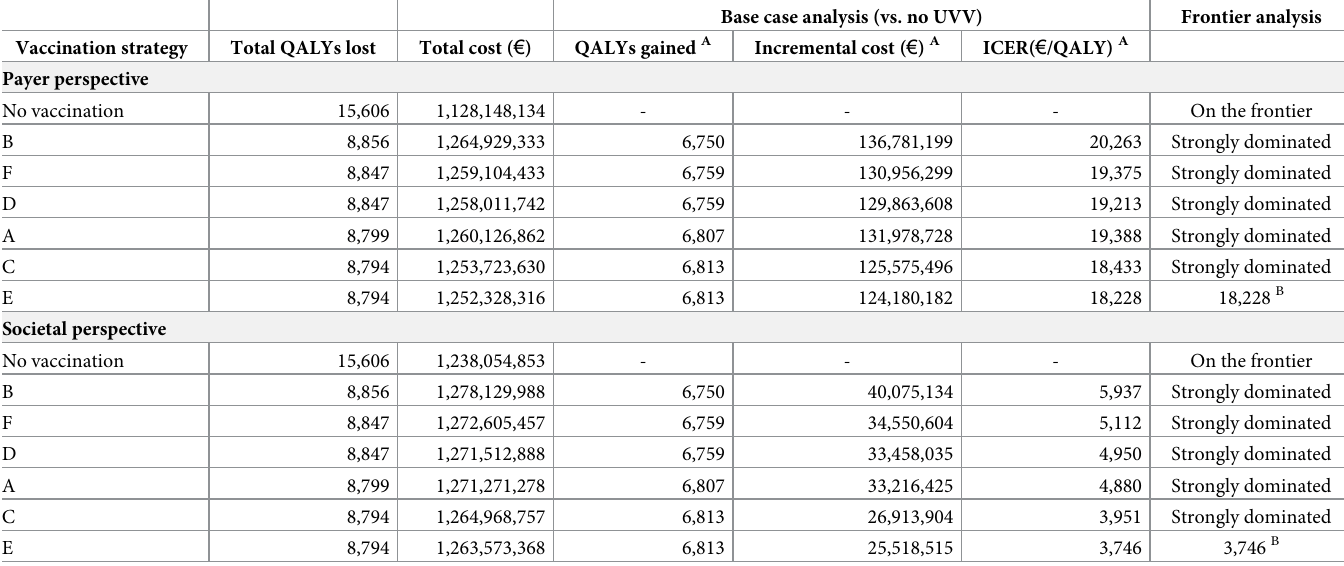
Table 3. Cost-effectiveness results of base case for varicella vaccination over 50 years, from payer and societal perspectives. Base case analysis (vs. no UVV) Frontier